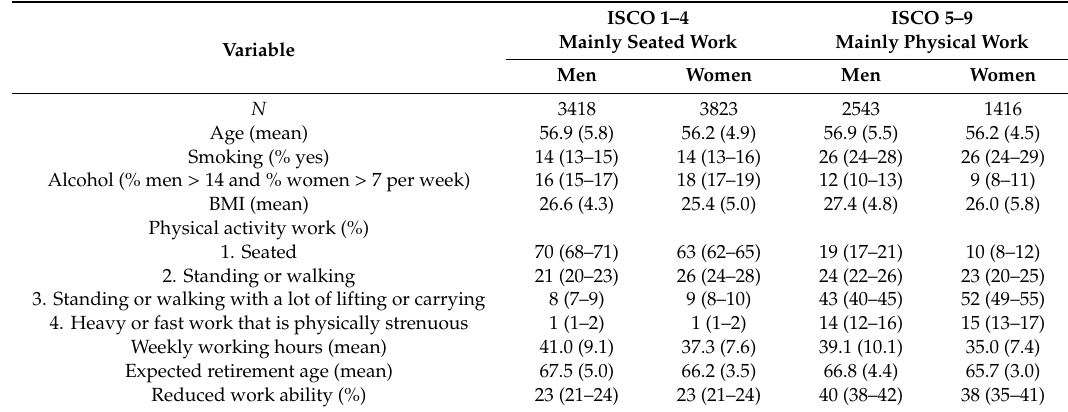
Table 1. Demographics, lifestyle, work and work ability among men and women in ISCO group 1–4 (mainly seated work) and 5–9 (mainly physical work), respectively. Results are either mean (SD) or prevalence as a percentage (95%